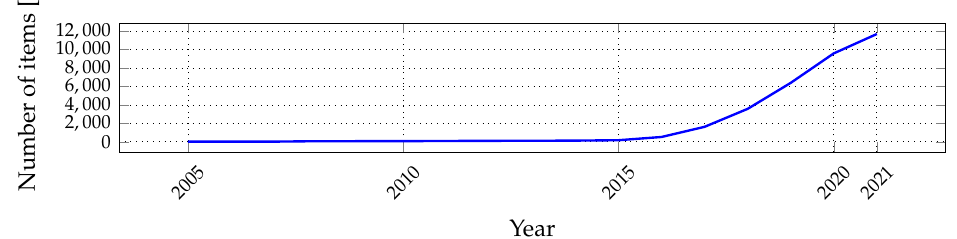
Figure 1. Results of keyword search of the term “LPWAN” in Google Scholar for selected years.